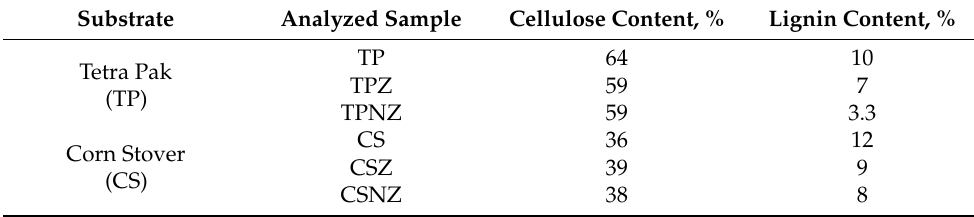
Table 1. Composition of TP, CS, and their pretreated